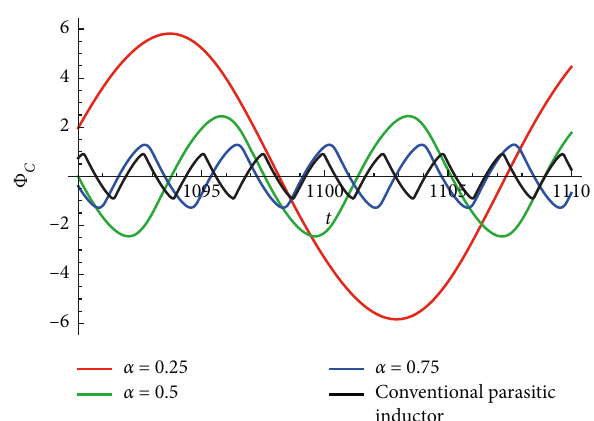
Figure 12: : q vs t of the memristor-capacitor circuit with the parasitic fractional inductor/conventional parasitic